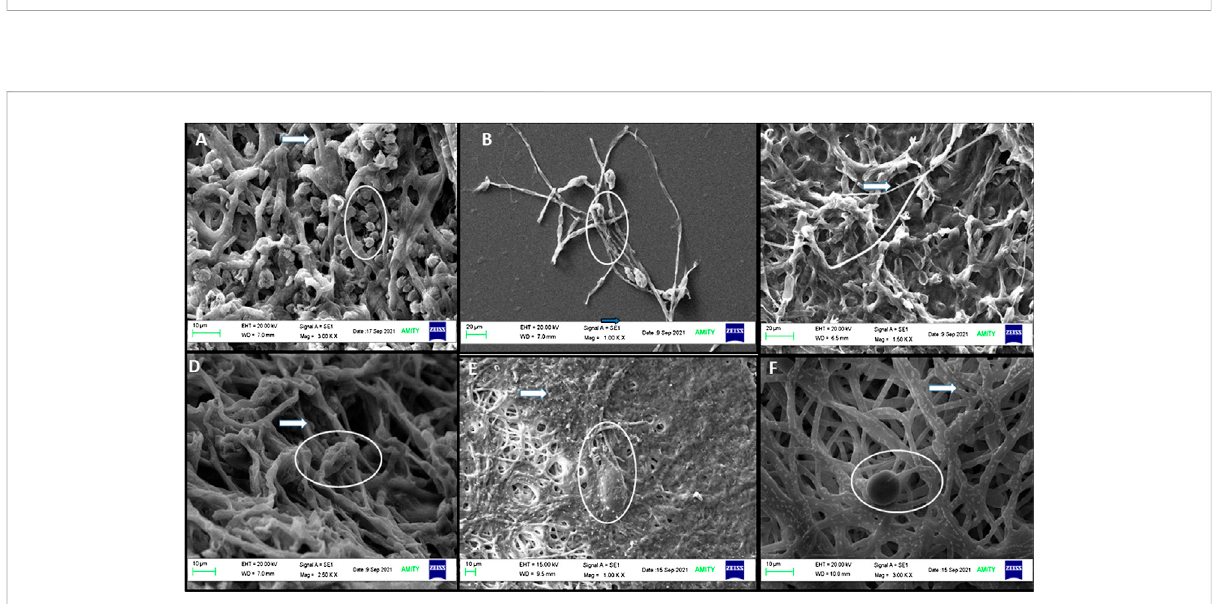
FIGURE 12 SEM imagesof A. brassicae after treatment with M and C - CuO NPs: (A,B) control: long obpyriform conidiaand maximum sporulation observed at 10 μ M and at 20 μ M; (C) A. brassicae after treatment with mancozeb (0.2%); (D) fractures were generated in hyphae after treatment with propiconazole (0.05%); (E) M - CuO NPs (200 ppm): deformed spores formed and disintegrated fragments with fractures in hyphae; and (F) C - CuO NPs: less spore and NP attachment on hyphal wall. All the above images showed conidia in circles and hyphae with